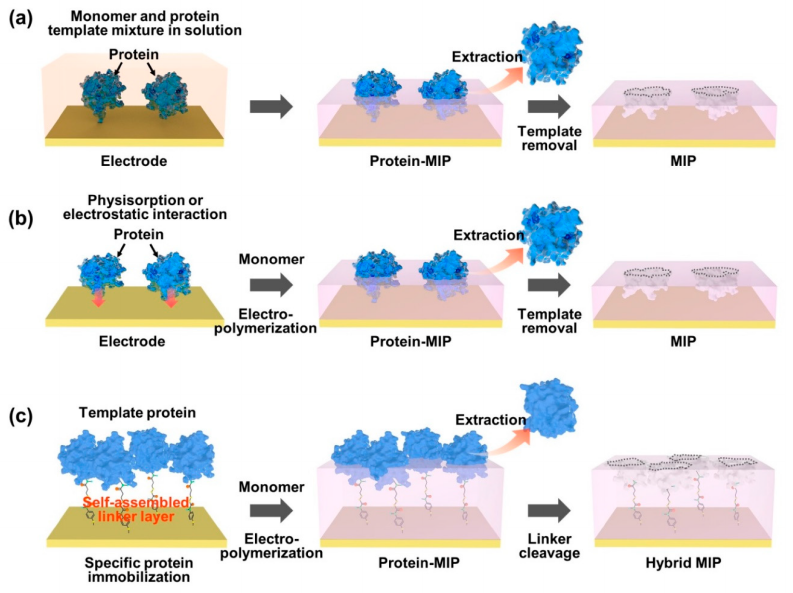
Figure 15. Representative strategies on the polymer surface imprinting process to construct specific recognition cavities (shown here for proteins, but equally applicable to smaller molecules). In an appropriate design concept, the selective rebinding site can be generated by using a functional monomer for electropolymerization on a prepared electrode surface, which includes the formation of the pre-polymerization complex ( a ), the template physisorption ( b ) and the immobilization of the target protein ( c ). Figure from reference